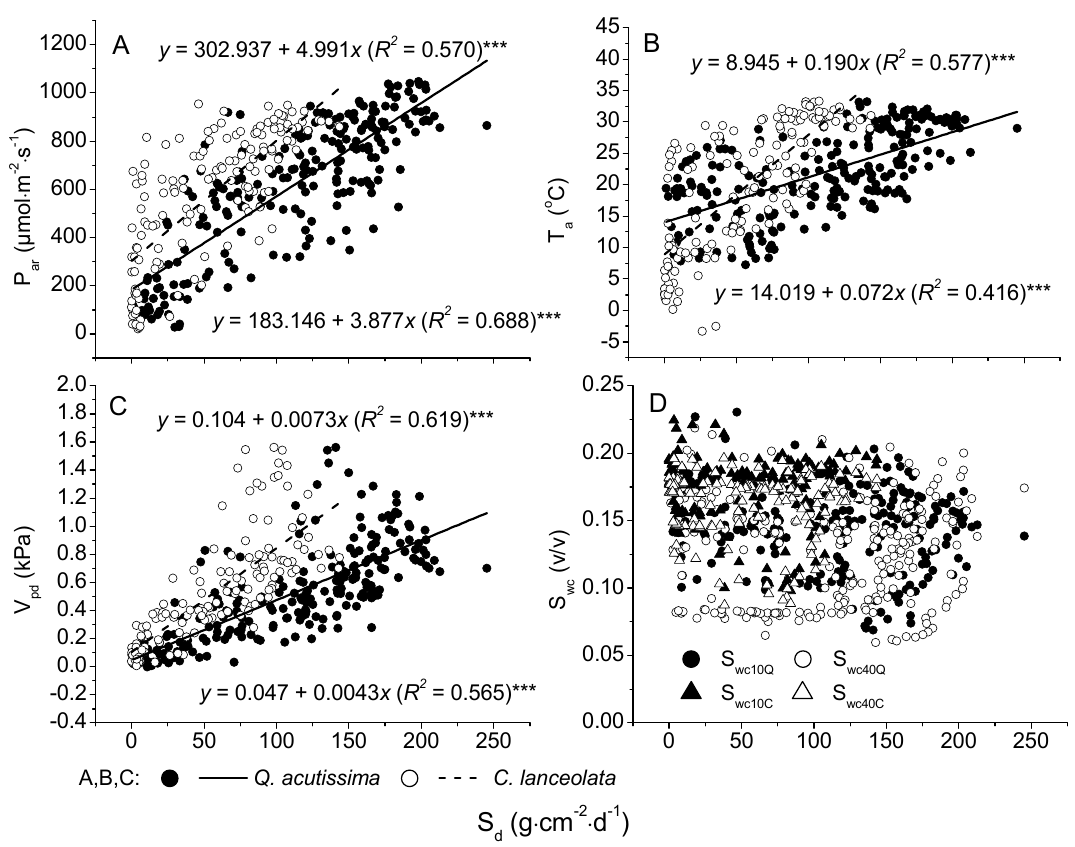
Figure 8. The linear relationship between daily sap flow density and environmental factors. *** Significant correlation at p < 0.001.